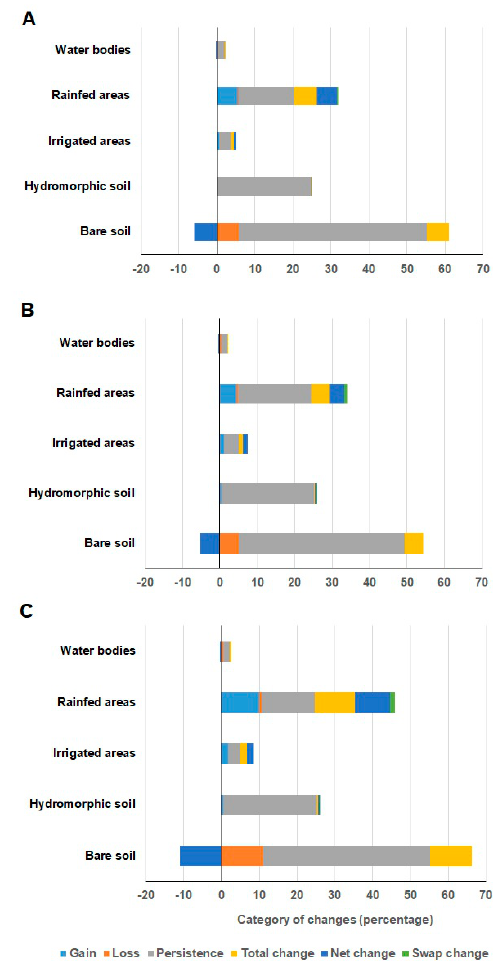
Figure 6. Quantity of LULC transition for three time intervals 1987–2000 ( A ); 2000–2015 ( B ); and 1987–2015 ( C ) across the Mogtedo region.